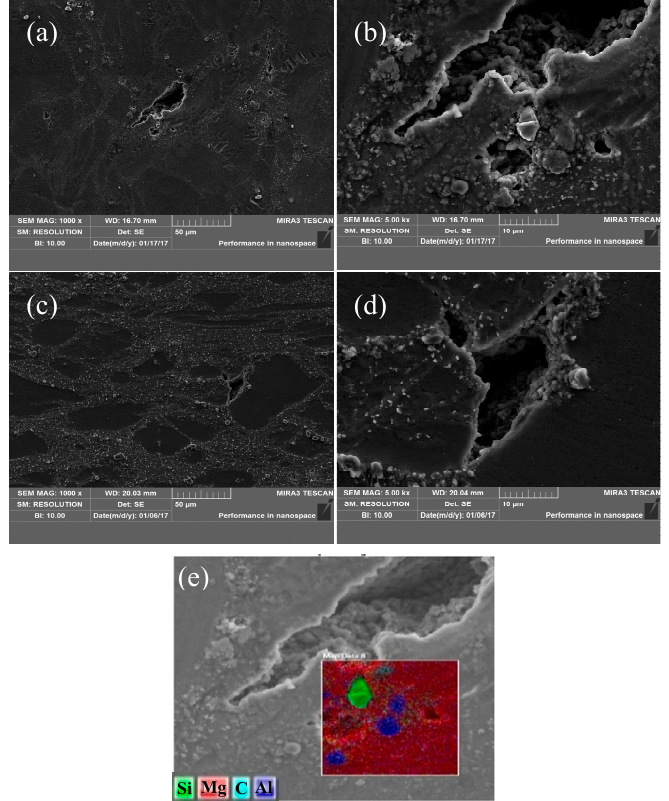
Figure 15. SEM images of nano-SiCp/AZ91 composite: ( a ) 523 K and 1 s − 1 , ( c ) 573 K and 1 s − 1 , ( b , d ) high magnification of ( a , c ), ( e ) the EDS of ( b ).